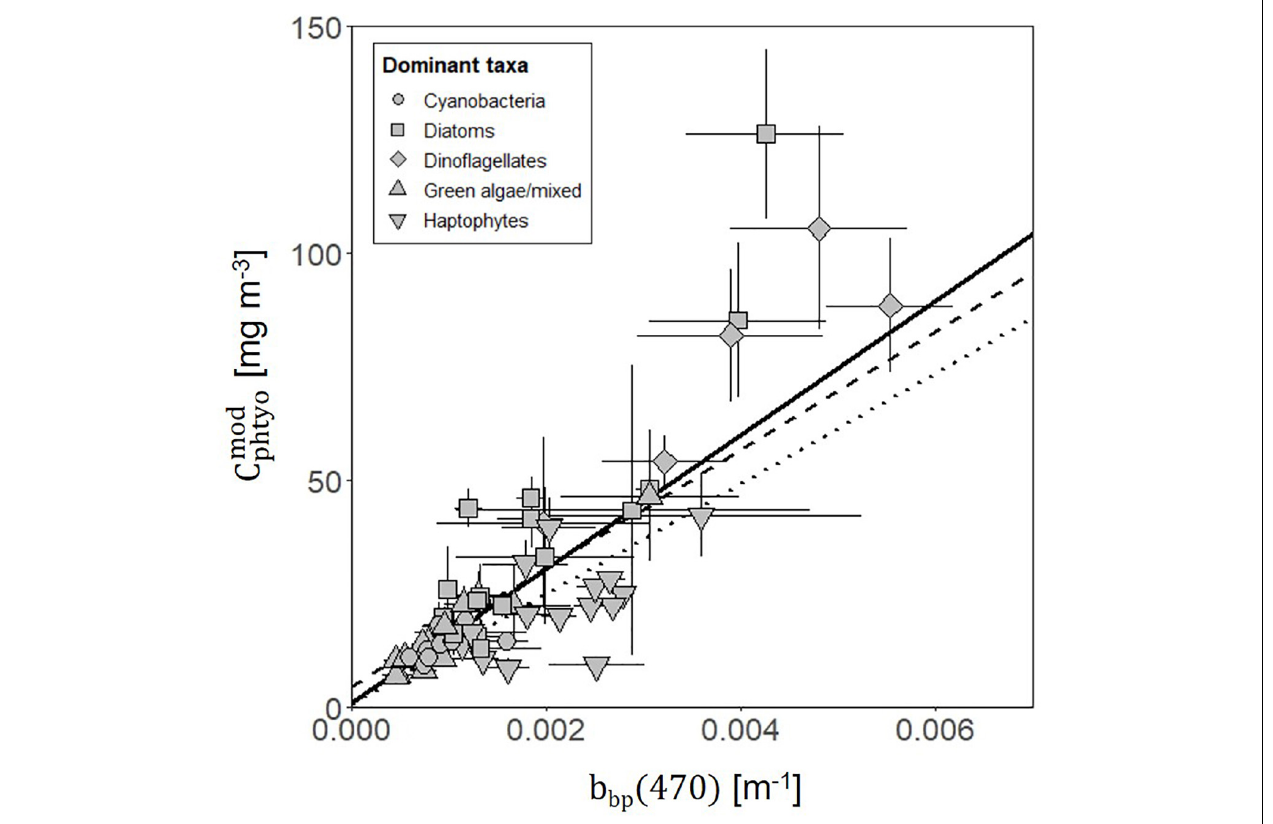
FIGURE 5 | Relationship between modeled phytoplankton carbon ( C mod phtyo ) values (derived from θ PaM and Chl ACS ) and measurements of particulate backscatter (b bp ( 470 ) ) (solid line; y = 14910x + 0.70, r 2 = 0.61, RMSE = 16.31) along the full science intensive transect from all four campaigns. Points show daily mean with error bars indicating standard deviations. Symbol shape indicates the dominant phytoplankton within the community, estimated using a community detection algorithm. Previously published relationships are also shown from Behrenfeld et al. (2005) (dashed line; y = 13000x + 4.55) and Graff et al. (2015) (dotted line; y = 12128x +